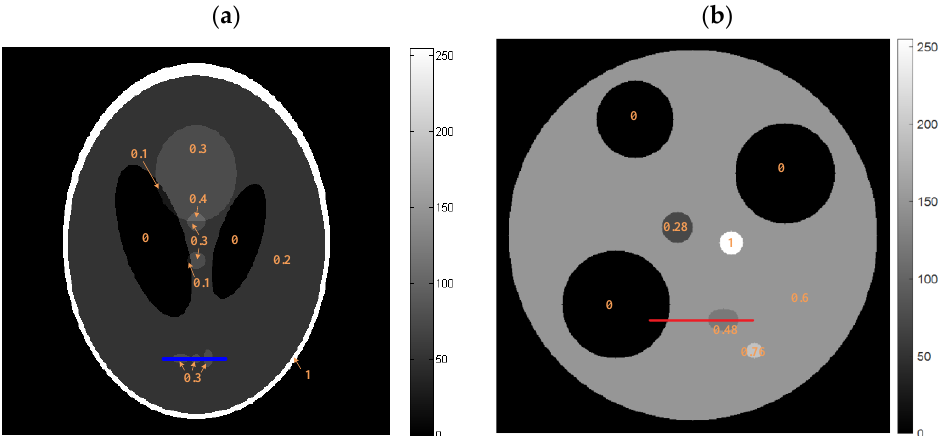
Figure 2. Simulated phantom. ( a ) Shepp–Logan phantom; ( b ) circular phantom. The display windows of two phantoms are set to [0, 255].